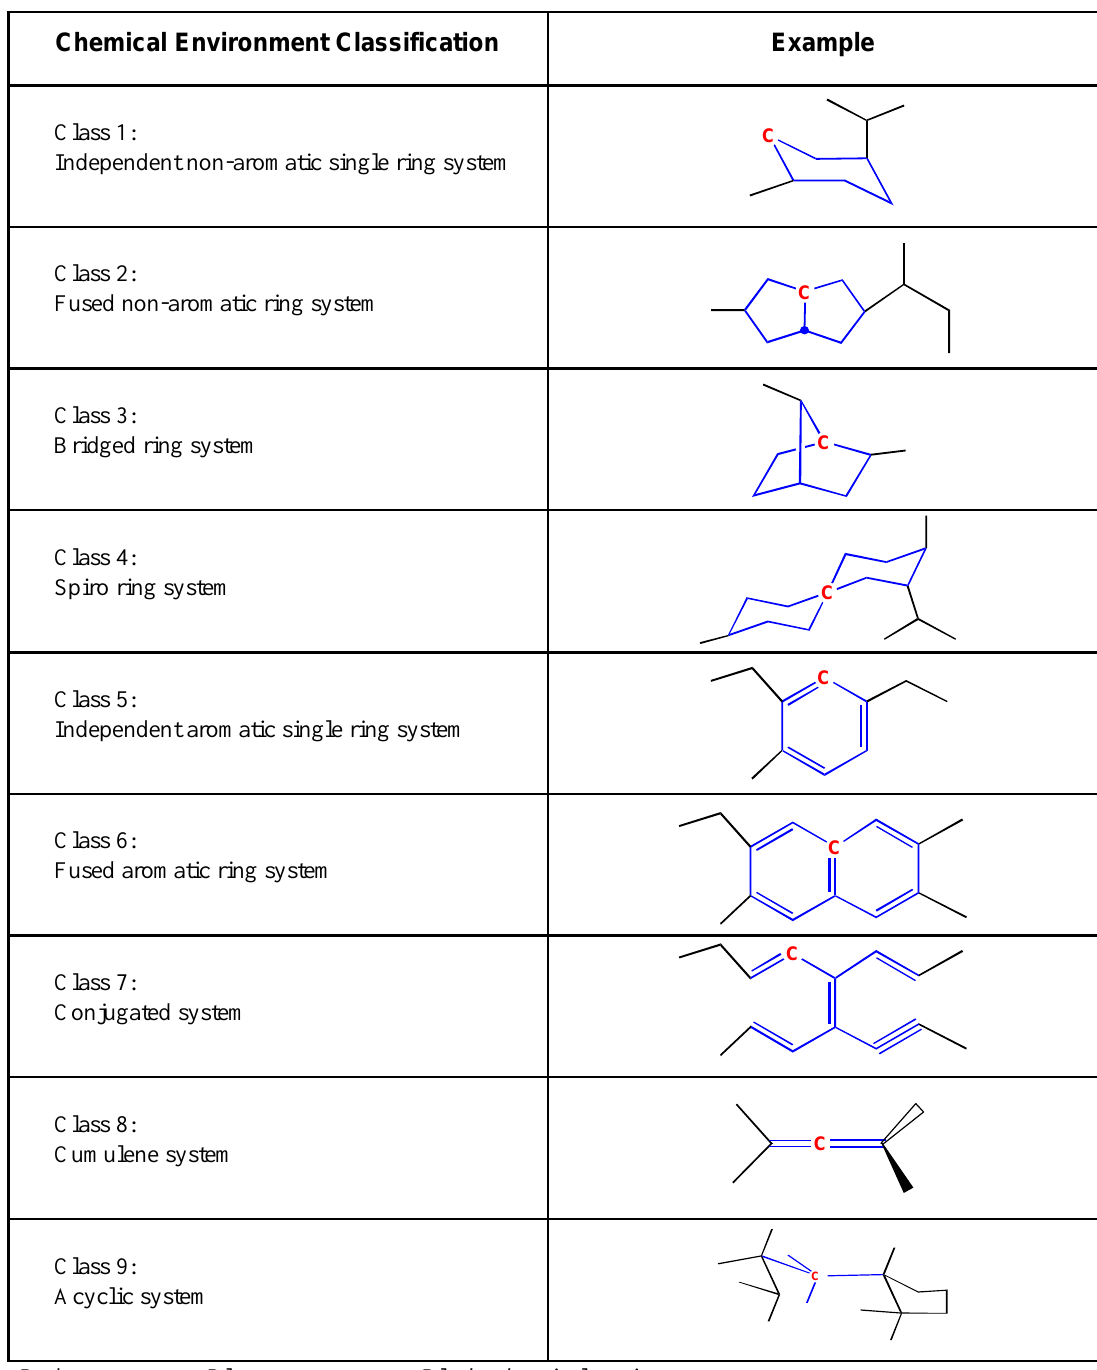
Table 1. Core structure